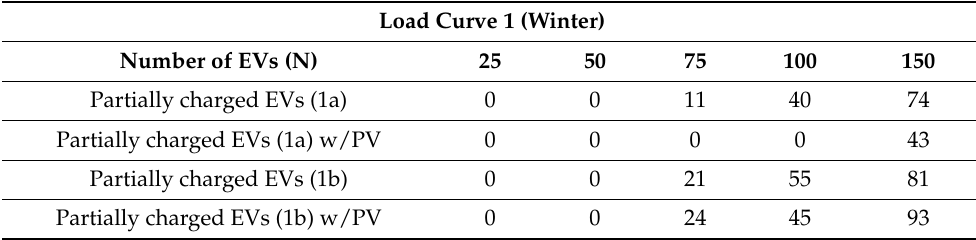
Table 1. Partially charged EVs for test cases 1a and